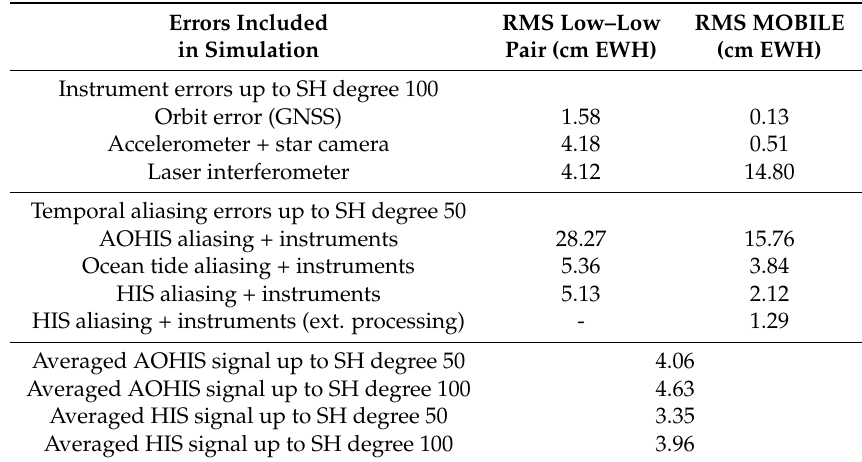
Table 3. Global RMS values in cm EWH for the low–low pair and MOBILE constellation considering different isolated error sources. RMS values are computed up to SH degree 100 for instrument errors, and up to SH degree 50 for temporal aliasing errors. Additionally, the global RMS value of the monthly averaged AOHIS and HIS signal is given (computed up to SH degree 50 and